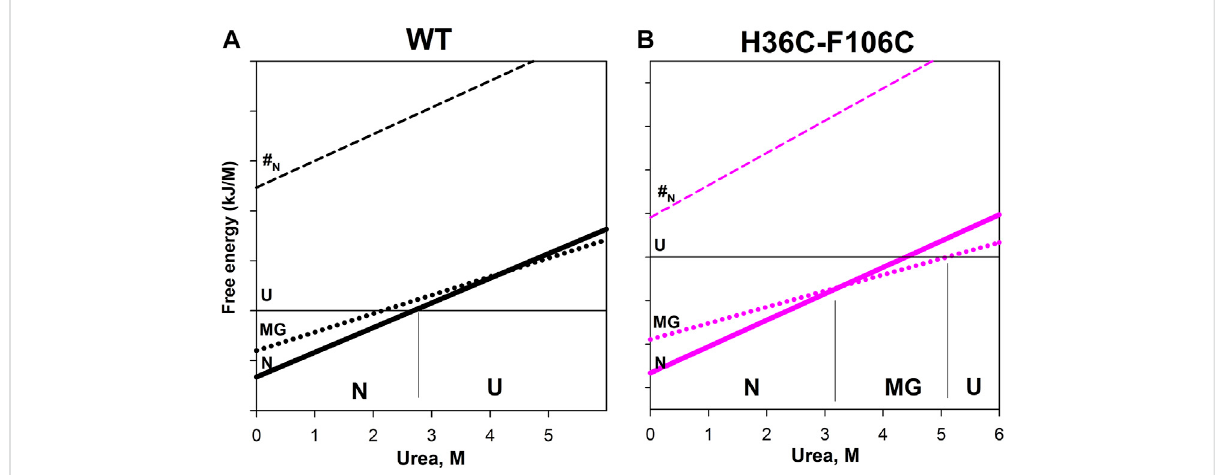
FIGURE 4 Free energy dependence of native state (N), molten globule intermediate state (MG), unfolded state (U), and transition state (#N) for wild-type apomyoglobin (A) and its mutant form with cysteine bridg (B) . The cut of such a dependence under certain conditions is the free energy pro fi le. For example, for wild-type apomyoglobin at 2.7 M urea, the free energy of the N state is equal to the free energy of the U state — the pro fi le for such conditions is shown in Figure 1. Near the lower axis, the letters N, MG and U indicate the most stable state at given urea concentrations. The division on the vertical axis corresponds to 20